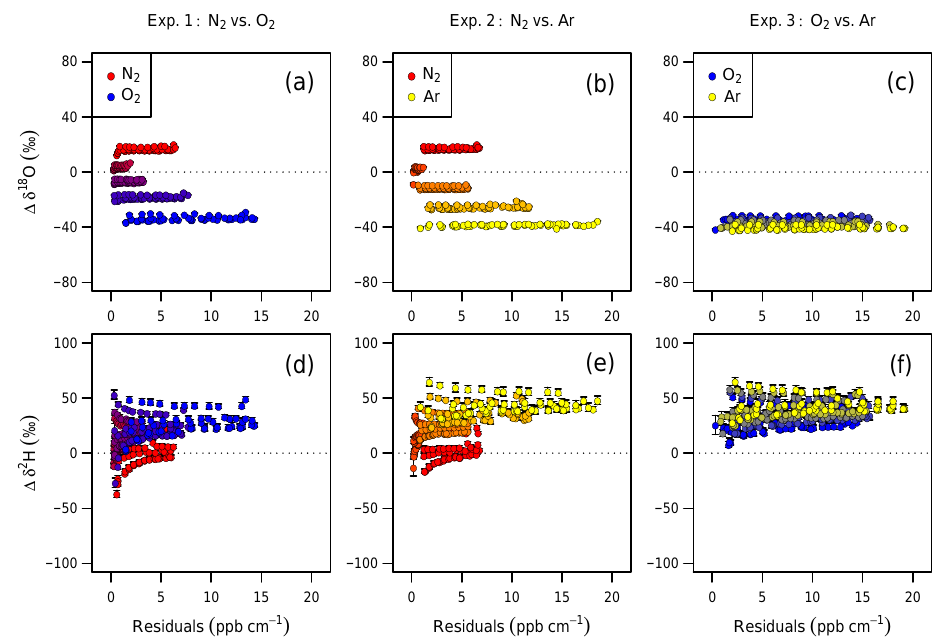
Figure 3. Relationship between the spectral residuals, (cid:49)δ 18 O, and (cid:49)δ 2 H values. For each panel, n = 330 measurements of four liquid standards across a range of injection volumes (i.e., 400–2400nL, in 11 steps of 200nL each). Points represent mean values ± SD for replicates of each standard at each injection volume. Table 3. Empirical models of the composite sensitivity of δ 18 O and δ 2 H values to all of the binary mixtures of N 2 , O 2 , and Ar. For significant predictors, coefficient estimates are given for β 5 and β 6 in Eq. (5); see text. Overall model fit is summarized with the residual standard error (RSE), adjusted R 2 , and P